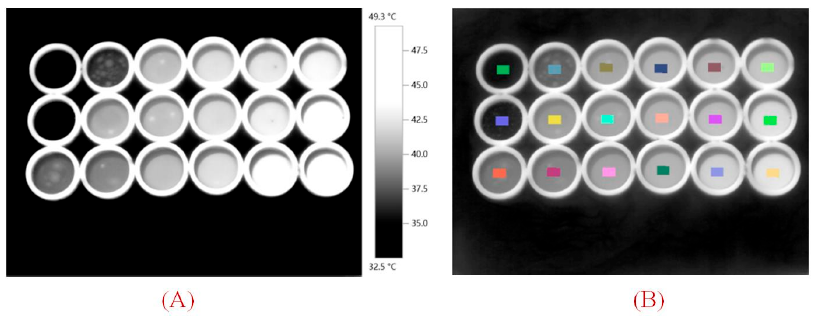
Figure 4. ( A ) Thermal infrared image on 3 August 2022 at 10:00; ( B ) Experimental sample (Colored rectangular squares: Selected experimental samples).